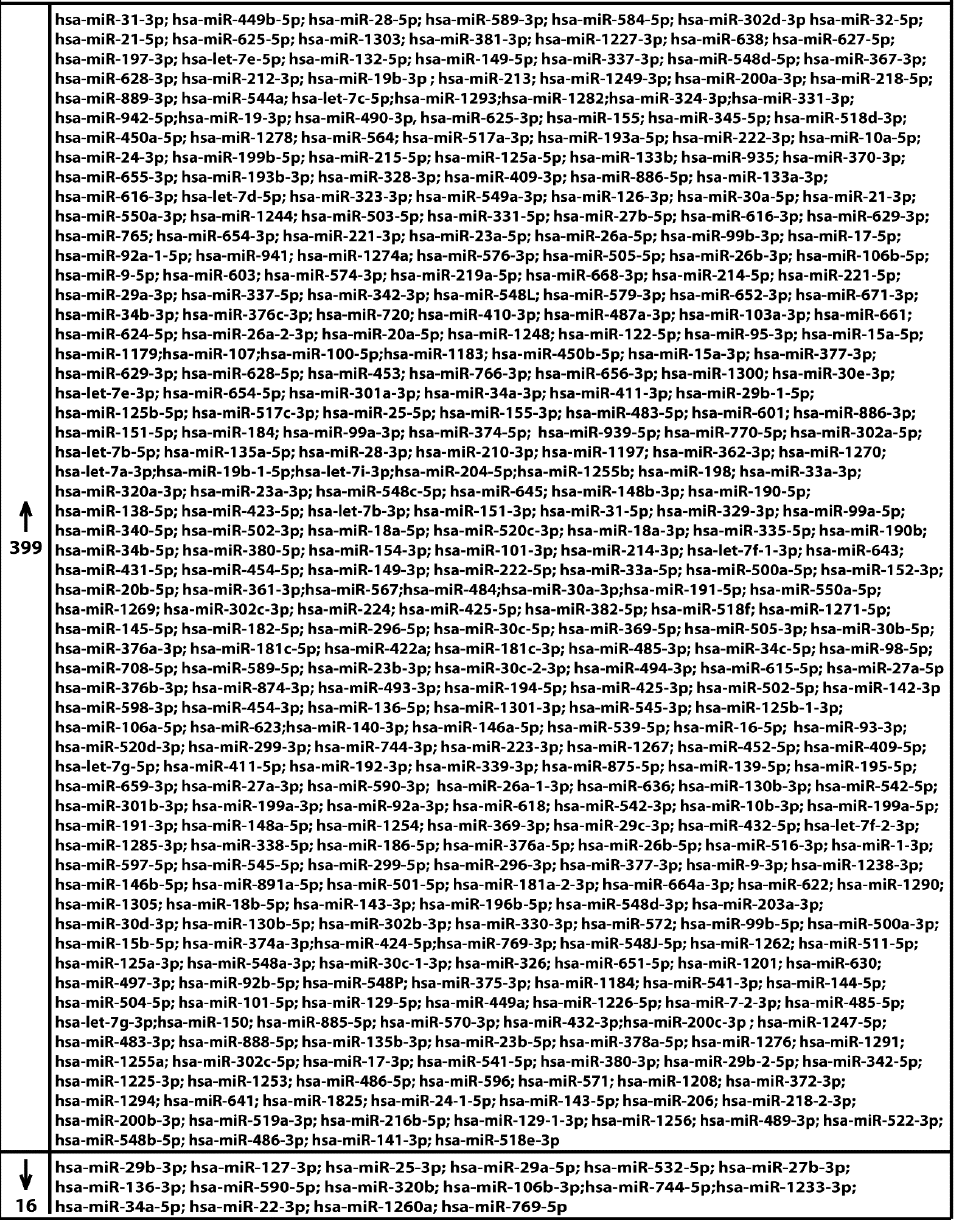
Figure 7. Identification of up ( n = 399) and down ( n = 16) regulated miRNAs in CAFs derived from a cutaneous metastasis of breast tumor and treated for 4 h with 100 nM E2.